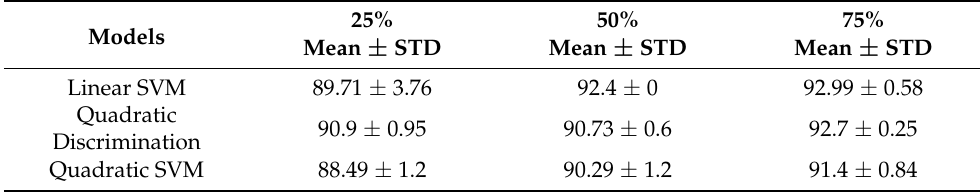
Table 2. Scenario 1 best classifiers.